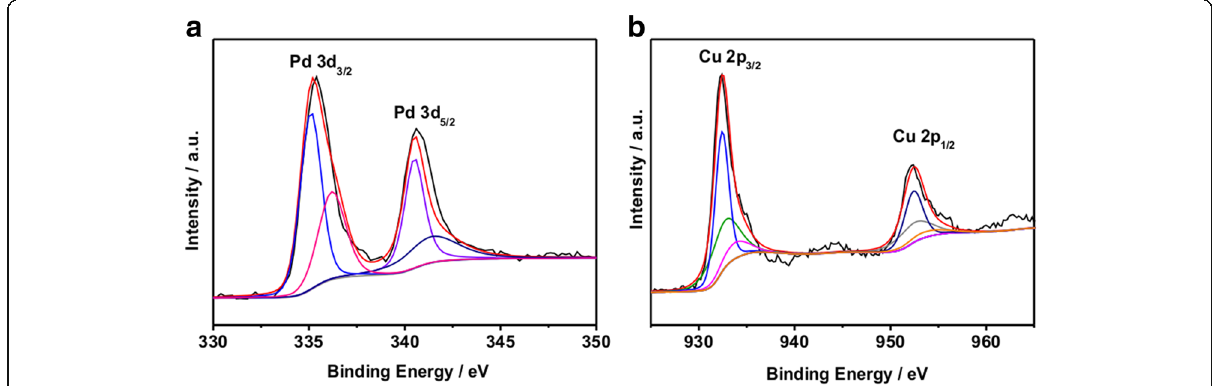
Fig. 4 Survey and high-resolution XPS spectra of Pd 3 d ( a ) and Cu 2 p ( b ) of Pd-Cu (F)